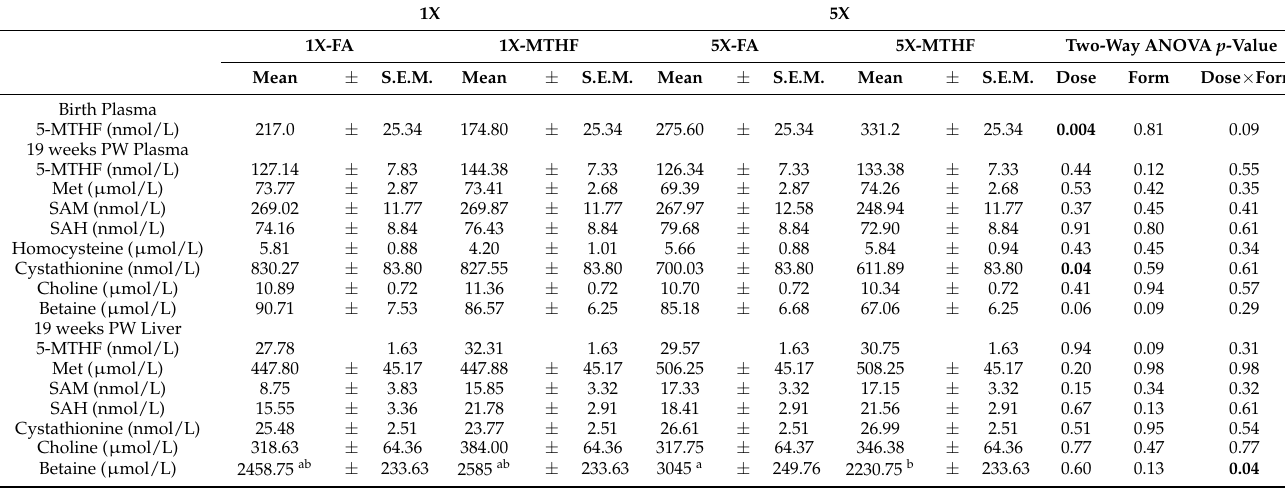
Table 3. Plasma and liver 5-MTHF and related 1-carbon metabolite concentrations in female offspring at birth and 19 weeks